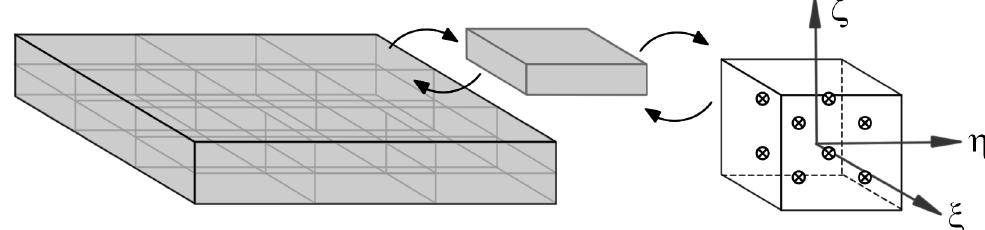
Figure 1. Integration scheme for the RPIM, using rectangular parallelepiped integration